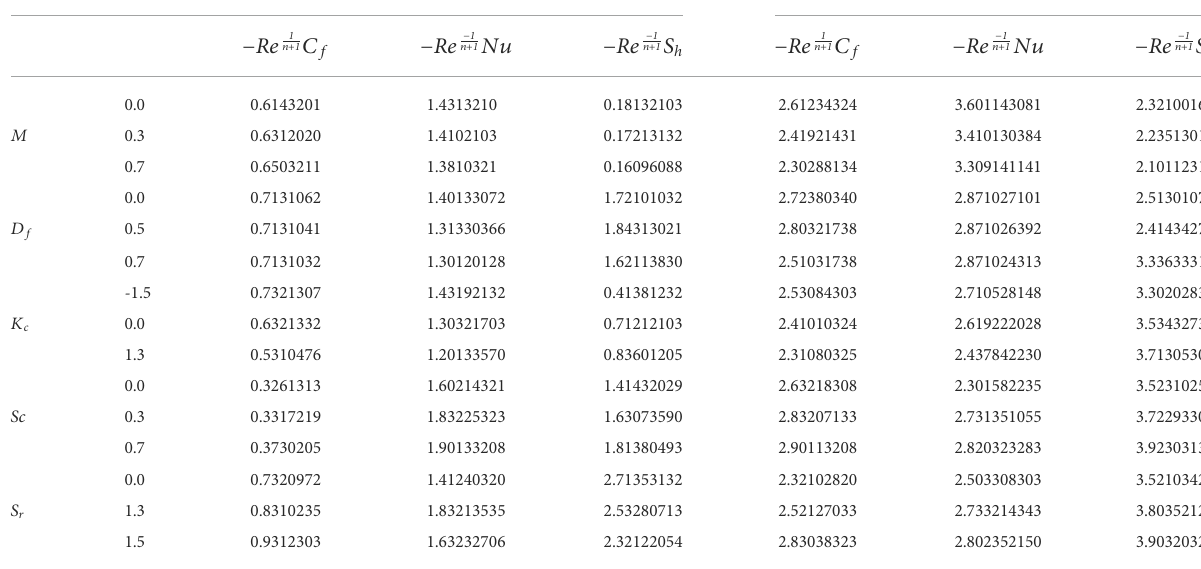
TABLE 4 Numerical behavior of fl ow rate, Sherwood number, and Nusselt number against M , Sc , K c , and D f . Nano fl uid